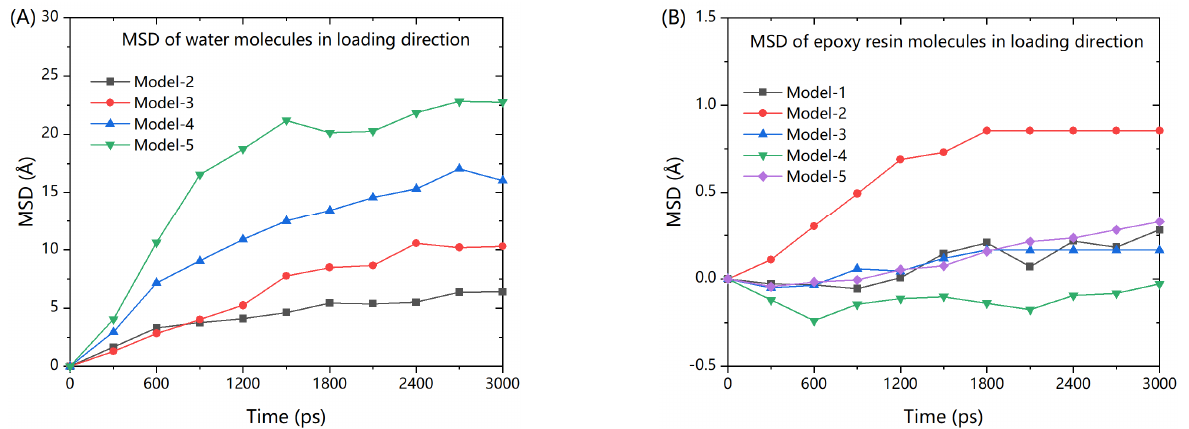
Figure 10. Mean-squared displacement of water molecules and epoxy resin molecules in the loading direction. ( A ) MSD of water molecules; and ( B ) MSD of epoxy